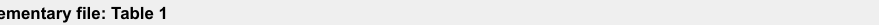
Supplementary file: Table 1 Characteristics* of subjects with asthma and COPD who report or did not doctor visits for respiratory symptoms in the SAPALDIA diary